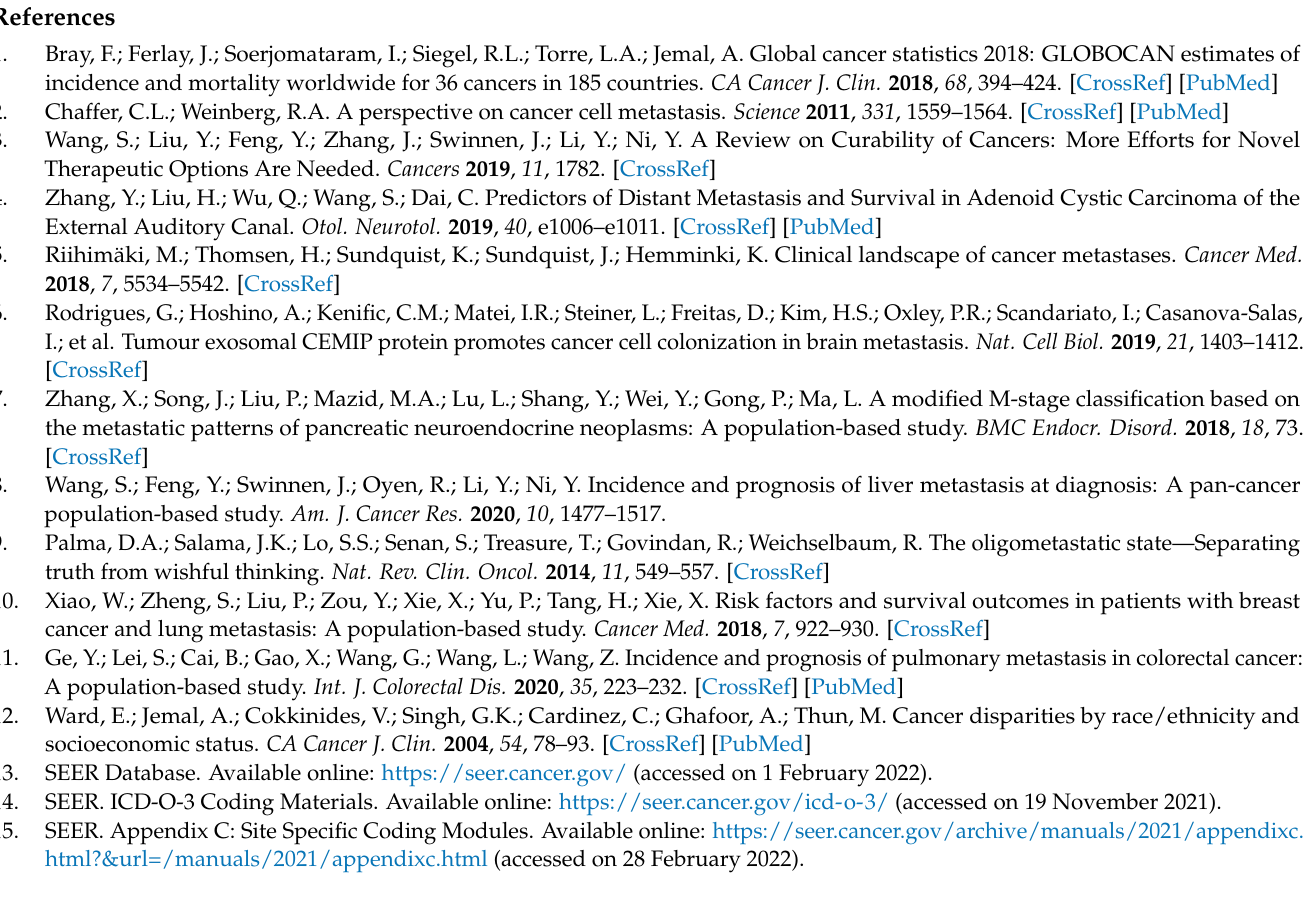
Supplementary Table S5. Number of cases with synchronous lung metastasis and all cases, prevalence of synchronous lung metastasis and median survival with interquartile range by cancer type and insurance status or marital